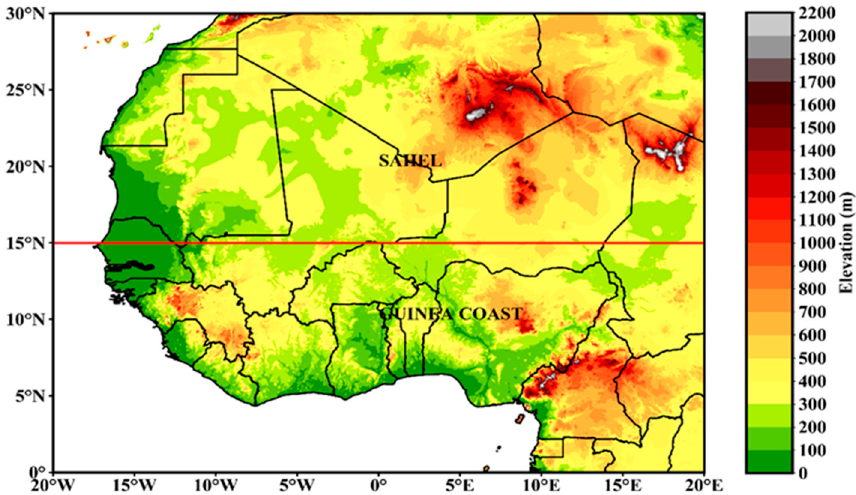
Figure 1. Map of the study domain showing the elevation of the study area. The division between Sahel and Guinea Coast is outlined by the red line.